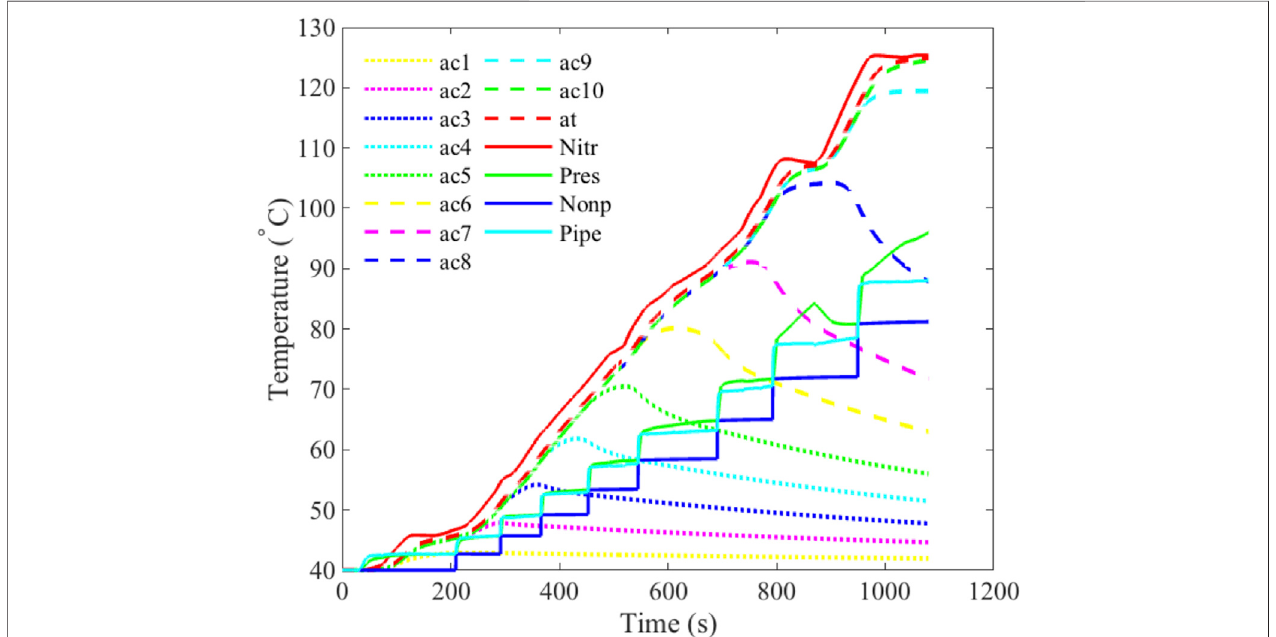
FIGURE 6 | Thermal characteristics of IHESS in the actual